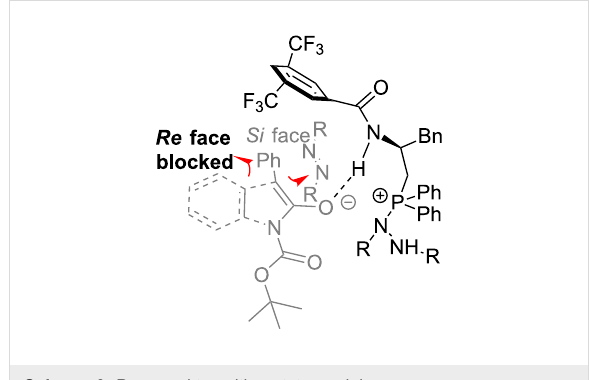
Scheme 3: Proposed transition-state